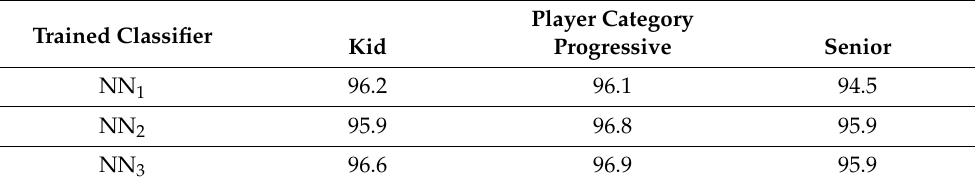
Table 3. Average recognition accuracy [%] in all experimental settings. Trained